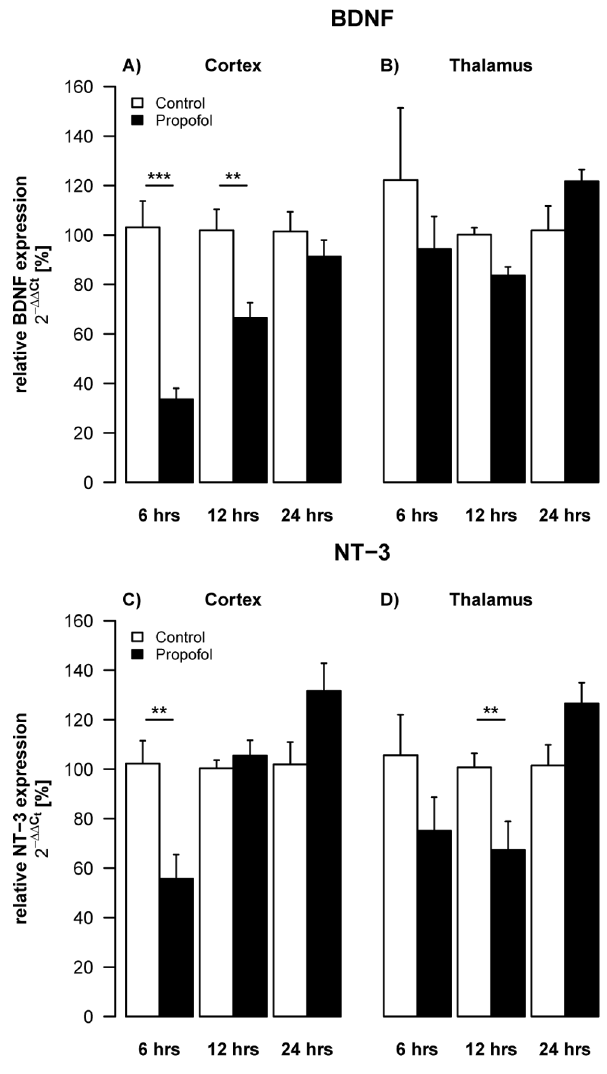
Figure 1. Impact of propofol on key proteins involved in apoptotic signalling. Densitometric quantifications of caspase-3 and AIF in cortex and thalamus of P6 rats as analysed by Western blotting. Values represent mean normalised ratios of the densities of caspase-3 and AIF bands compared to densities of the control group (n=5–6/ point + SE). There was an effect of propofol treatment on caspase-3 levels over time, which was significant after 24 hrs in the cortex [F(1,29)=3.63, p=0.06] and after 12 hrs in the thalamus [F(1,28)=3.1, p=0.09).